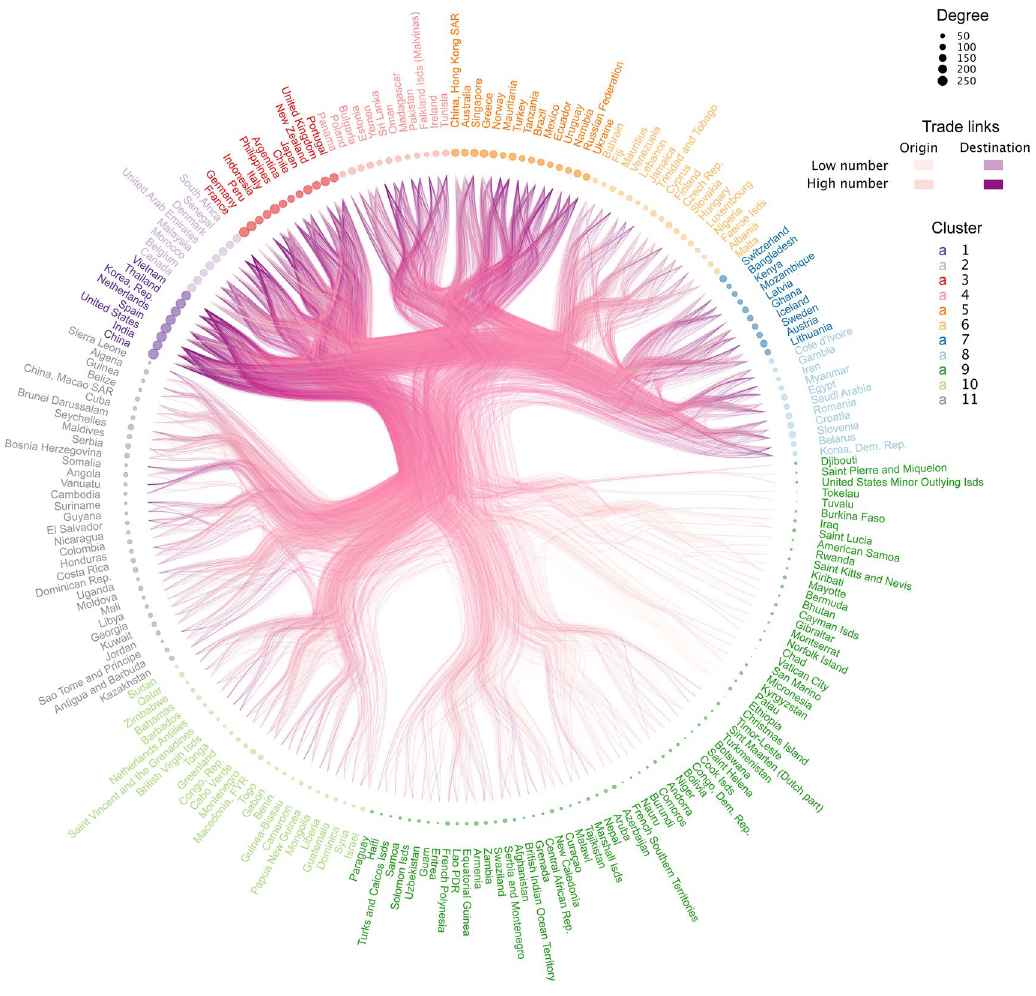
Figure 3. The Cephalopod Global Trade Network. The top 220 traders of the CGTN as nodes (circles) and their trade links as lines. The colour and the size of the nodes represent, respectively, the cluster membership and relative importance of the trader in the CGTN, estimated from the number of trade links with other traders (i.e., degree). The colour of the edges represents the origin, destination and the proportion of trade links for all years between each pair of traders. The clusters were made using Ward’s method. The figure was created with R